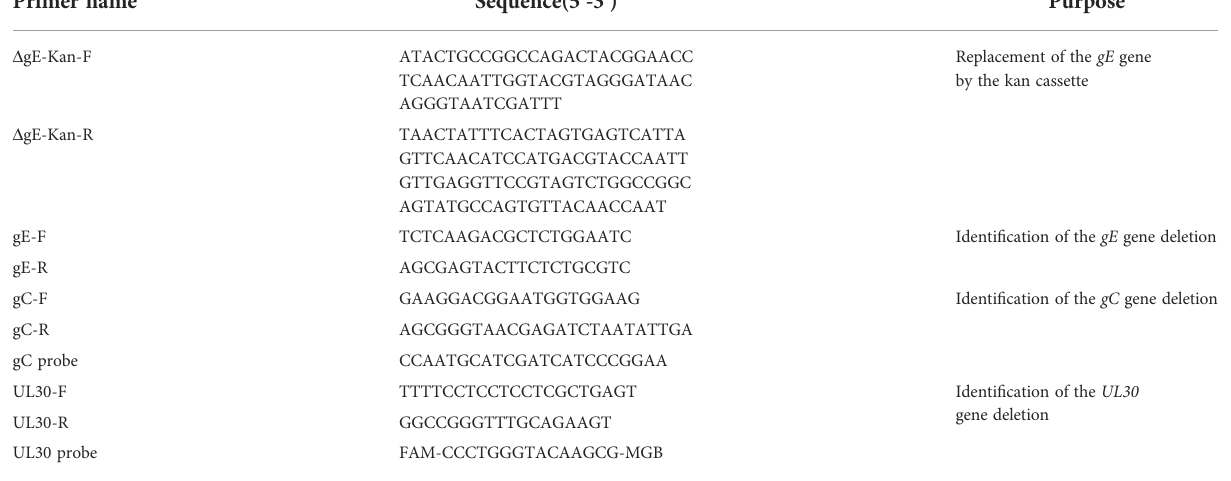
TABLE 1 Primers of construction and identi fi cation of deleted recombinant